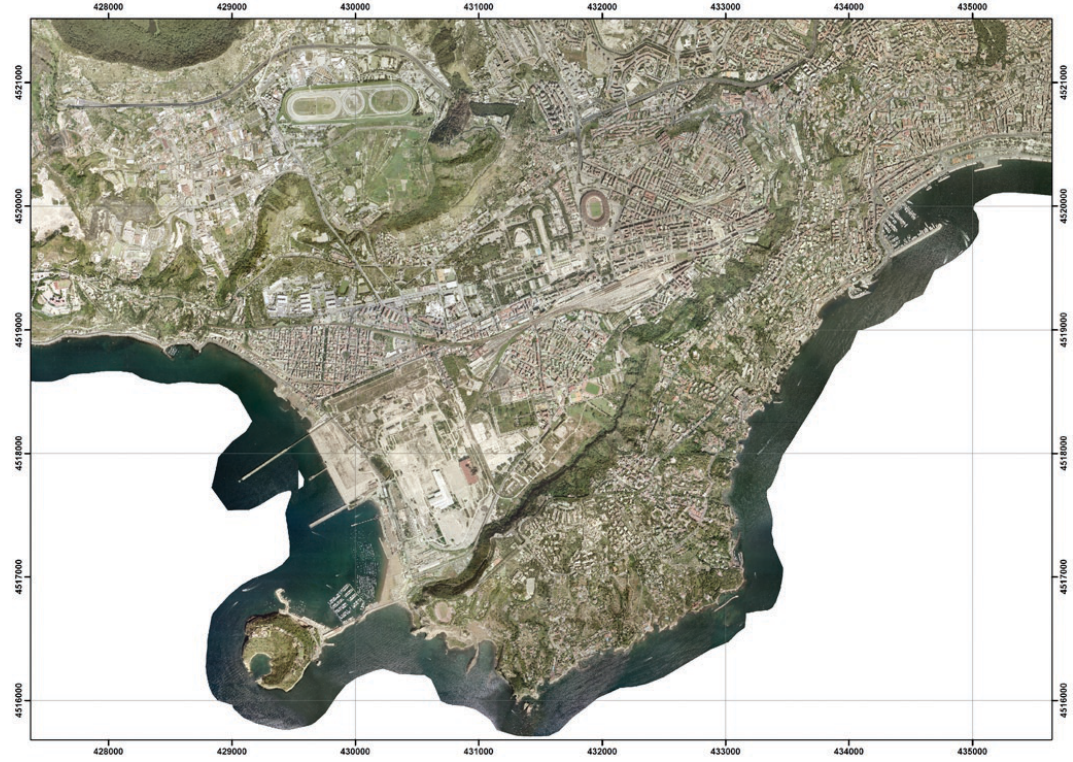
Fig. 22. Ortophoto of the Posillipo hill. Source: Campania Region – Department of Land Use Policies; year: 2004–2005; spatial resolution: 0.2m ×